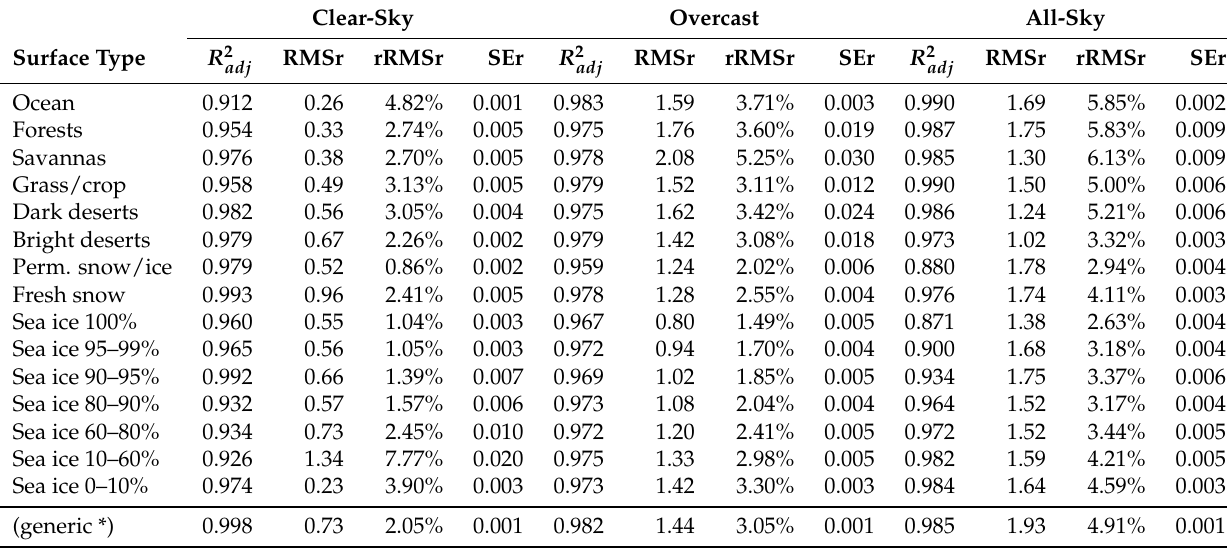
Table 4. Regression metrics based on calibration subset (80% of the NTB pairs with strict matching criteria), stratified per surface type, for clear, overcast, and all-sky conditions; Data: 2004–2005 (NOAA17+Terra), 2007–2008 (NOAA18+Aqua) and 2011–2012